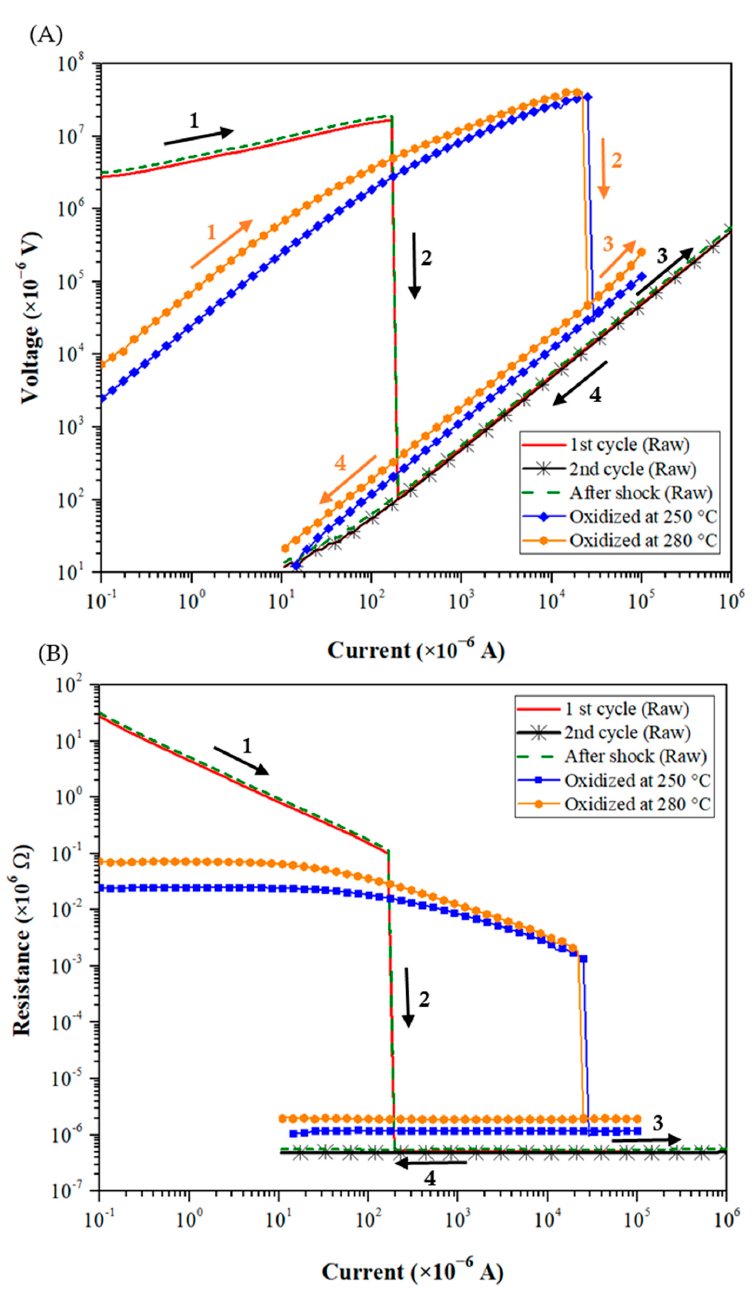
Figure 4. Typical U-I ( A ) and R-I ( B ) characteristics (logarithmic scale) measured during current cycles up to 1 A for the raw and oxidized Cu powders before and after mechanical shock.